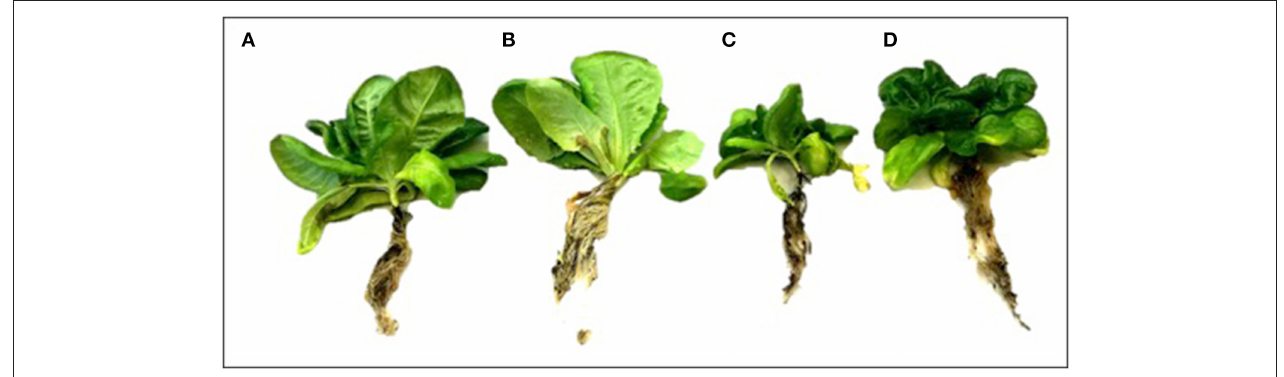
FIGURE 4 | Morphology of lettuce plants after 90 day in each treatment. Uninoculated (S–) plant without salt stress (A) ; Plants inoculated with a mix of Antarctic microorganisms (S + ) not subjected to salt stress (B) ; S– plants under salt stress (200mM NaCl) (C) ; S + plant under salt stress (200mM NaCl) (D) . Image credit: H. Hansen.